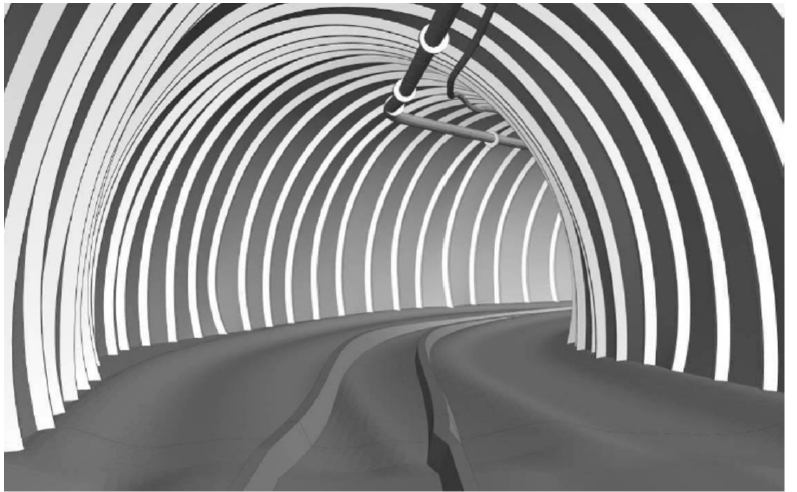
Figure 12. Obtained geometry model, view of the mine tunnel straight section near the bend (Reprinted from Ref. [70]).